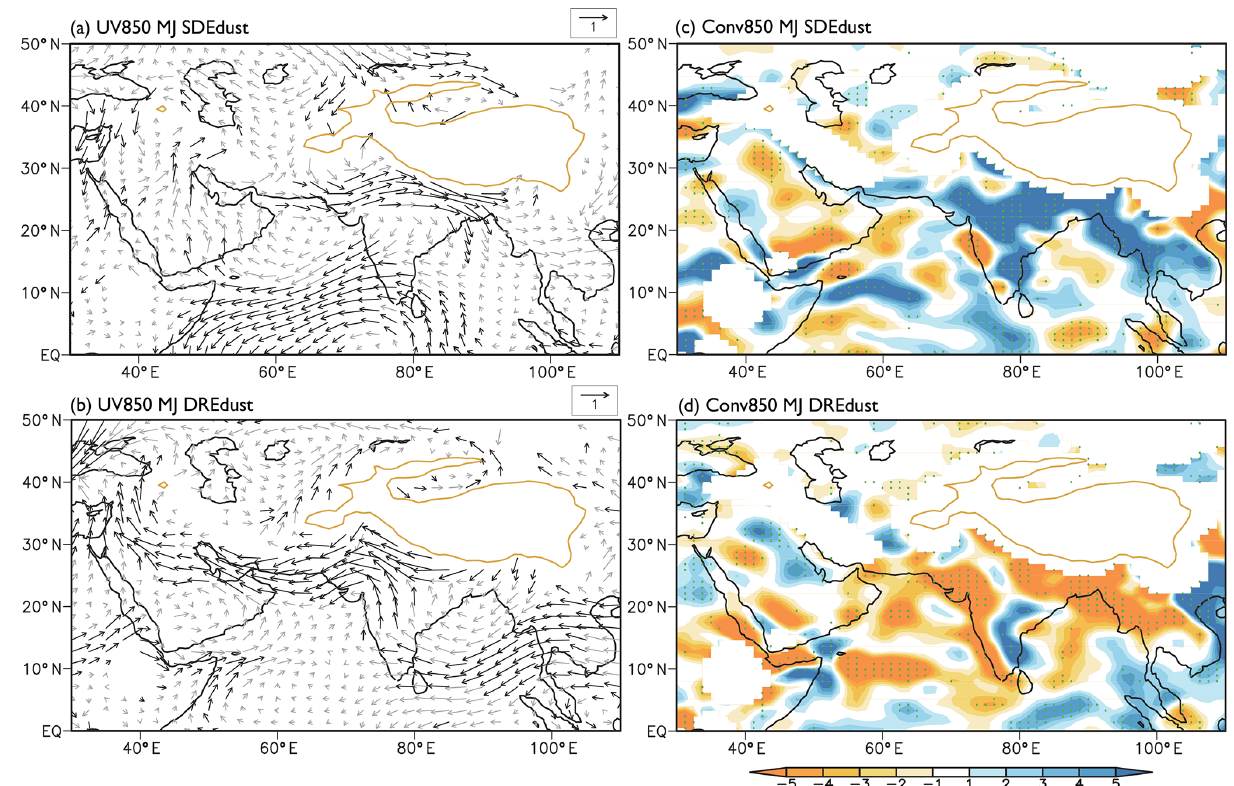
Figure 6. Spatial distribution of changes in 850hPa wind vectors ( a, b , ms − 1 ) and moisture convergence ( c, d , gskg − 1 m − 1 ) in May and June induced by the snow-darkening effect (a, c) and direct radiative effect of dust (b, d) , respectively. Positive values in (c) and (d) mean divergence anomaly and a negative value means convergence. Black arrows and green dots indicate differences significant at the 90% confidence level. Yellow line shows the profile of the Tibetan Plateau above